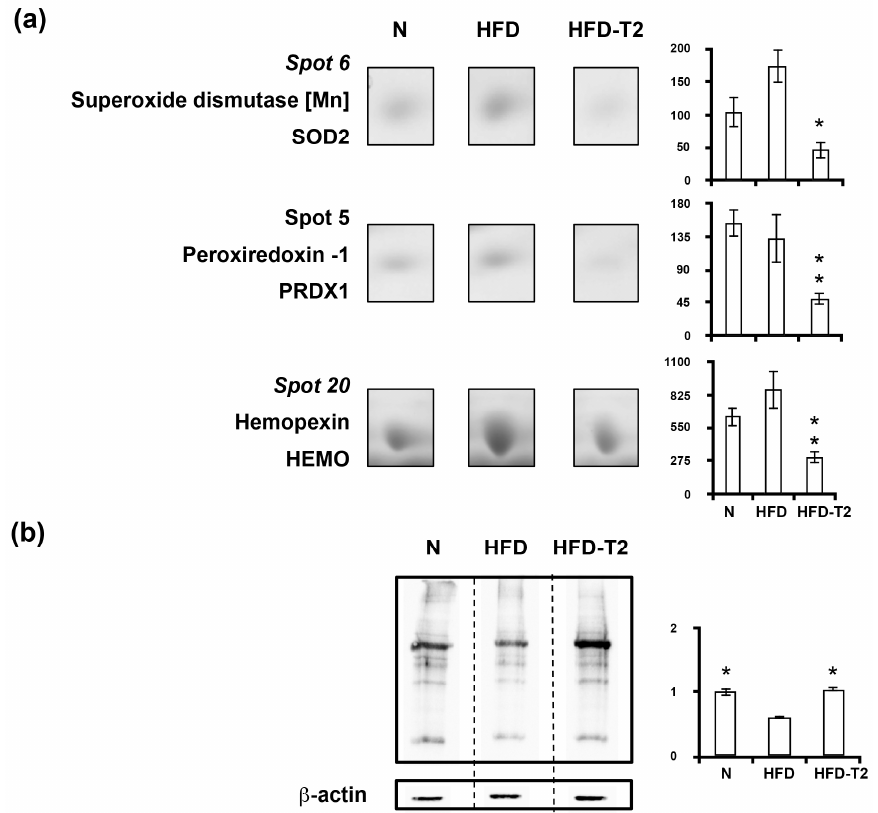
Figure 9. Four-week 3,5-T2 treatment-associated differential representation within the VAT proteome with regard to antioxidant proteins. ( a ) Representative subsections of 2D-E images of VAT of N, HFD, HFD-T2 rats. Results are expressed as arbitrary units (means ± SEM; n = 4) ( p < 0.05). Spot numbering refers to Figure 5a. ( b ) Representative immunoblot showing protein carbonylation in VAT of N, HFD, and HFD-T2 rats. Protein load was 30 µg/lane. The vertical dotted lines indicate cuts in the membrane. Data were normalized to the value obtained for N animals (set as 1). Shown are the mean values ± SEM ( n = 4). * p < 0.05 vs. HFD.